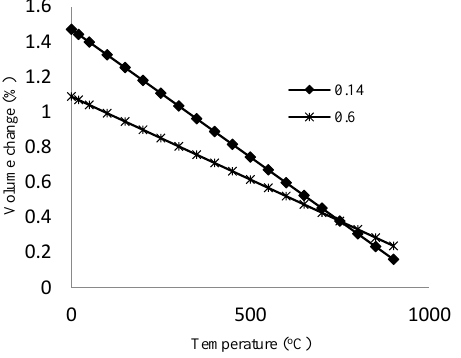
Figure 4. Time Temperature Transformation (TTT) diagram of AISI 1045 steel [9]